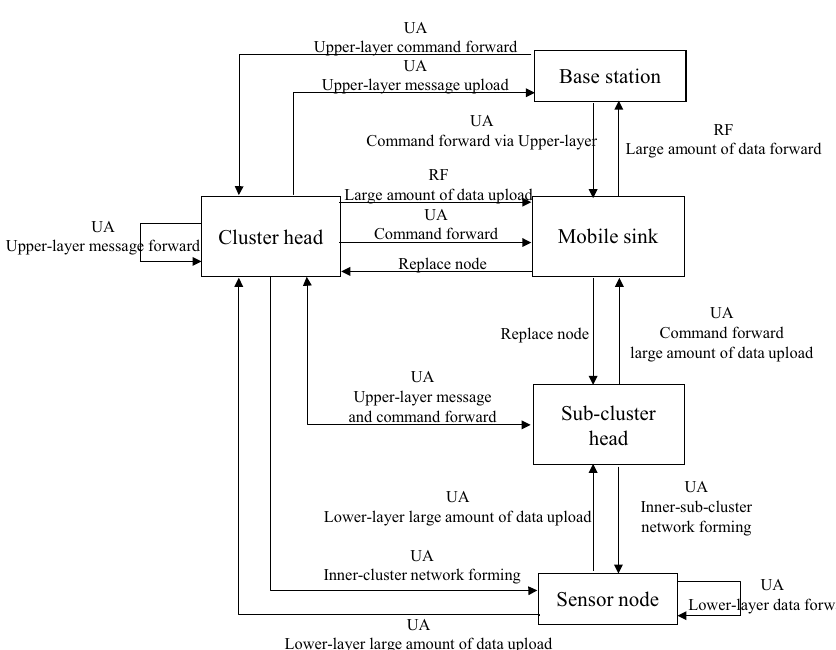
Fig. 2 Data forwarding direction and nodes status transfer